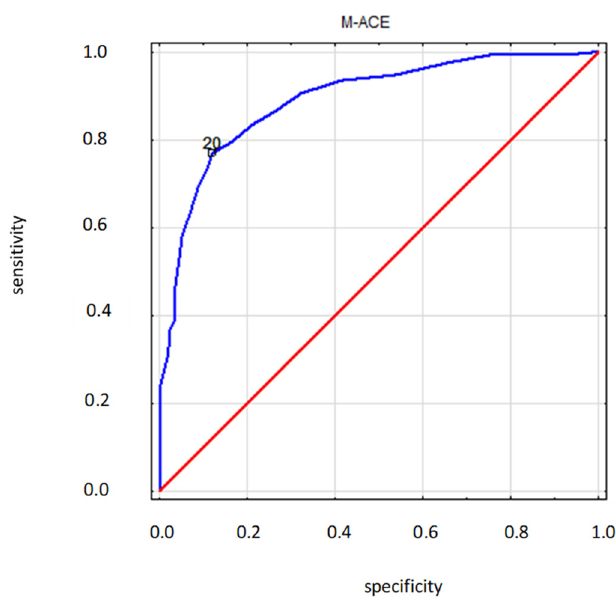
Figure 13. ROC curve (blue) of M-ACE for the MMSE state variable. Diagnostic variable—M-ACE (destimulant); State variable—MMSE: 0—norm (27–30 pts), 1—below norm (0–26 pts). ACE-III and MMSE—three categories (Dementia, MCI, Norm); red—random classifier.